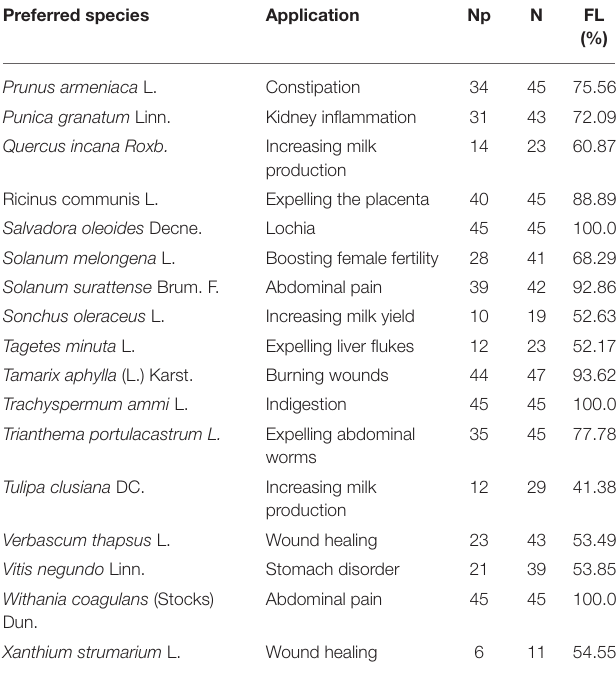
TABLE 5 | List of reported species with treated disorders and their fidelity level